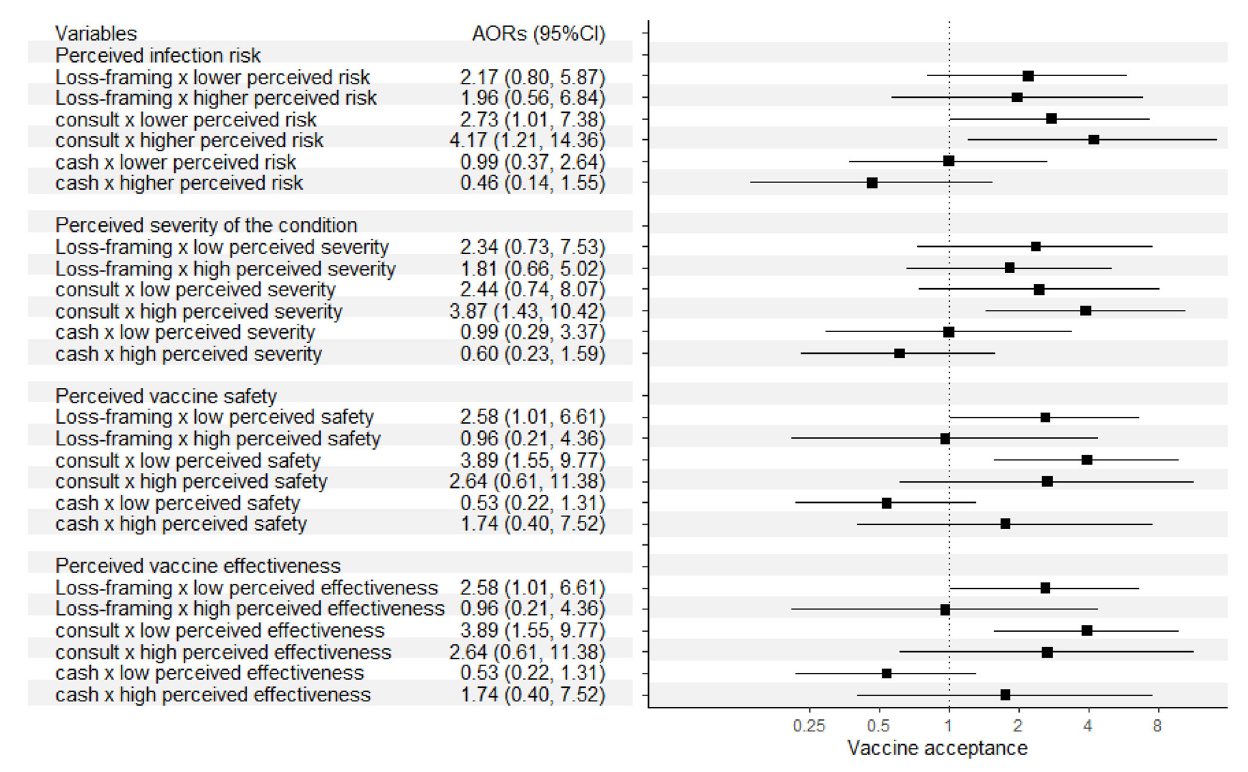
FIGURE2 Effects of the three strategies according to different perceptions of the participants who did not received the